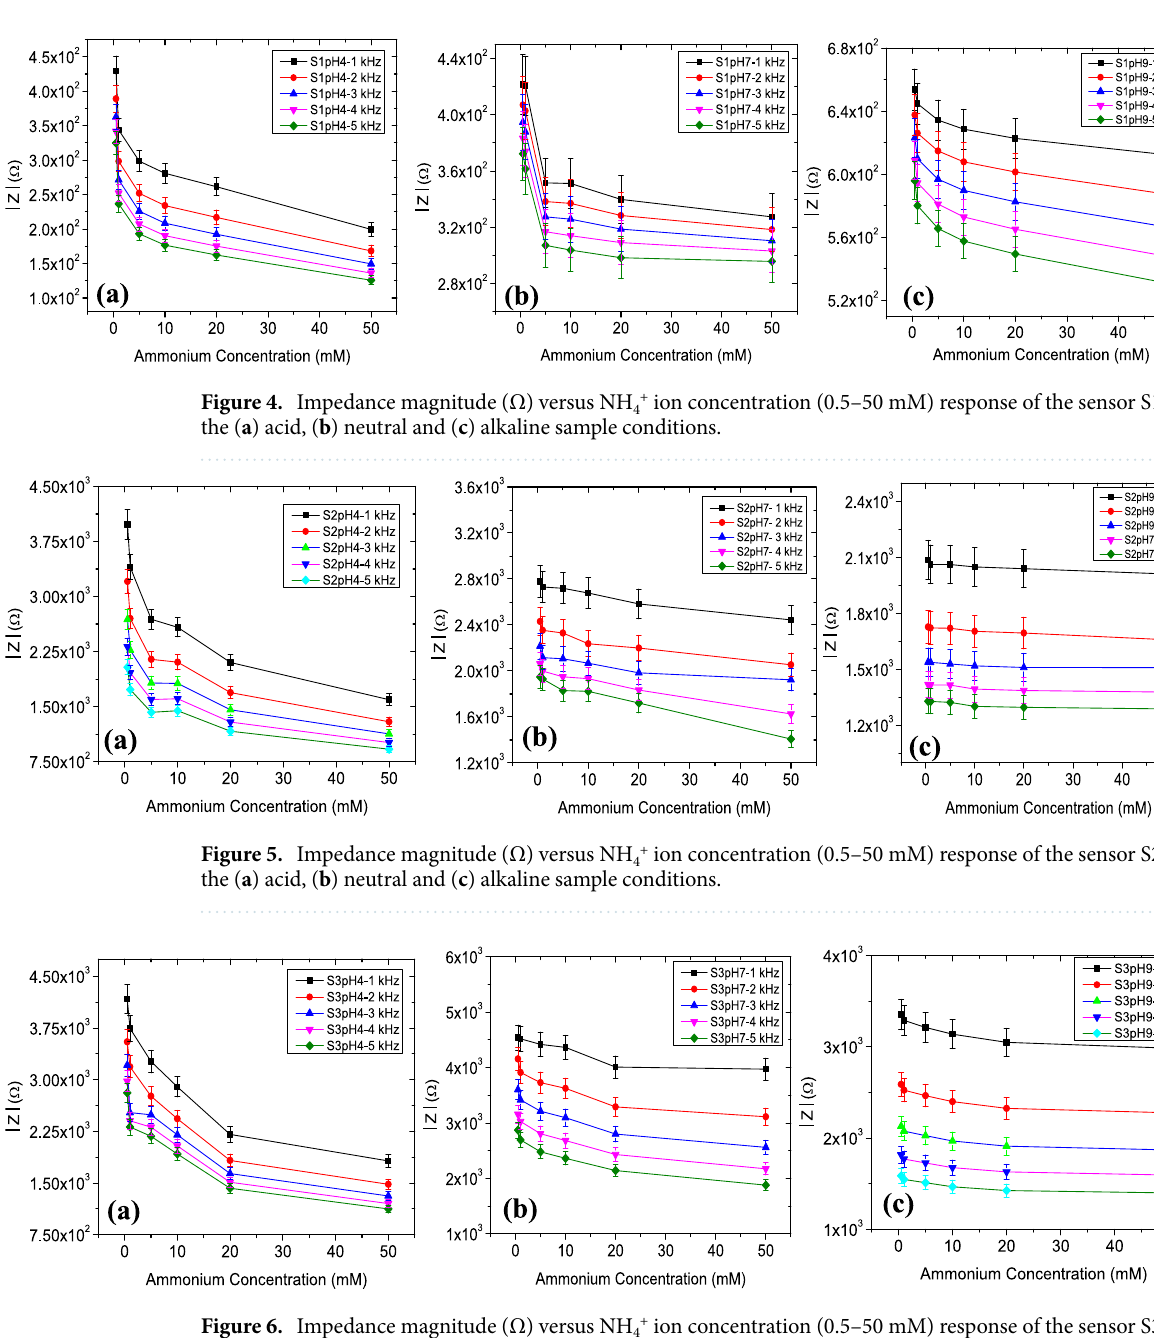
Figure 6. Impedance magnitude (Ω) versus NH 4+ ion concentration (0.5–50 mM) response of the sensor S3 in the ( a ) acid, ( b ) neutral and ( c ) alkaline sample (Figs. 4b, 5b, 6b) and alkaline (Figs. 4c, 5c, 6c) conditions. The device sensitivity to NH 4+ was also found to vary